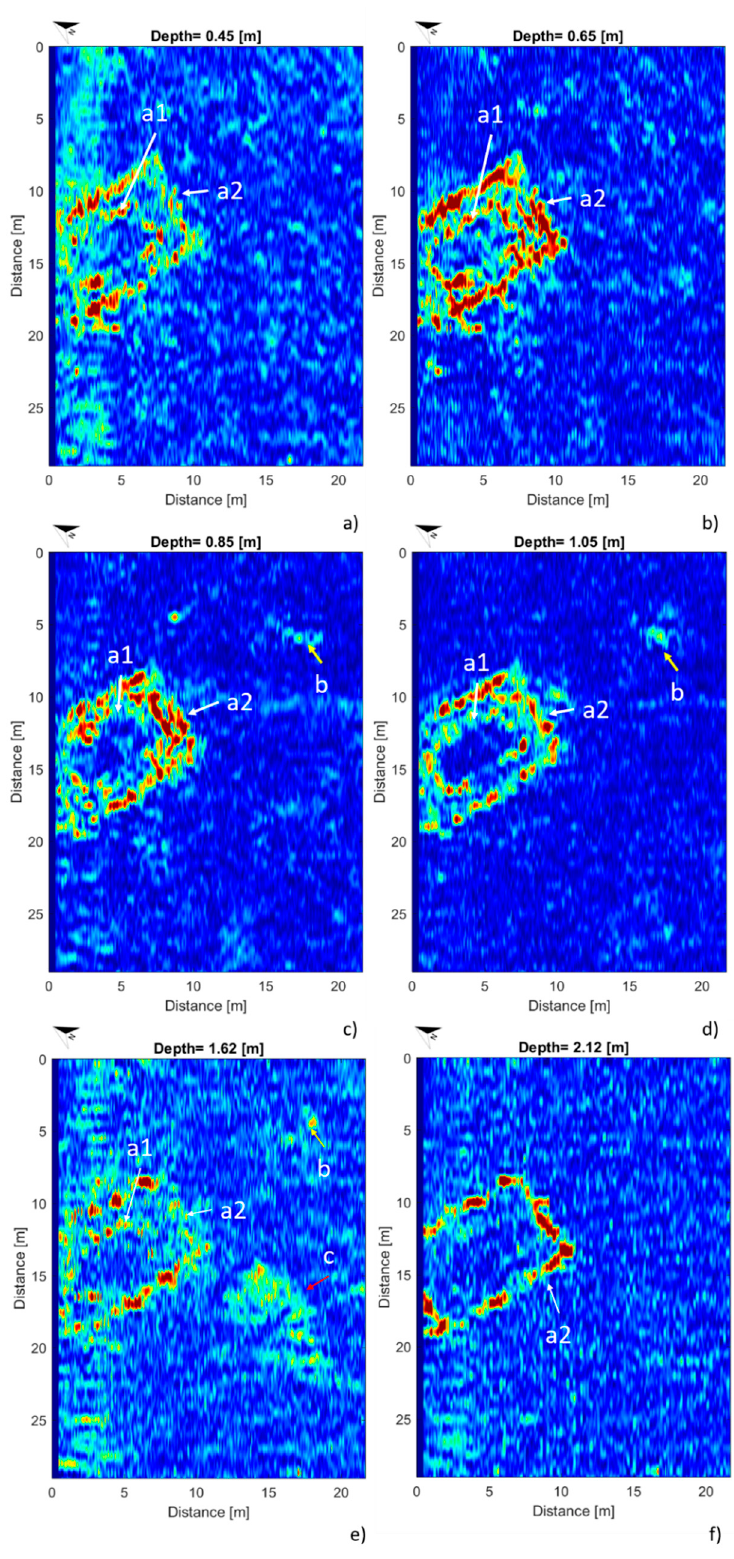
Figure 8. Constant depth slices of the GPR tomographic images at 200 MHz. The main anomalies are indicated by labels and